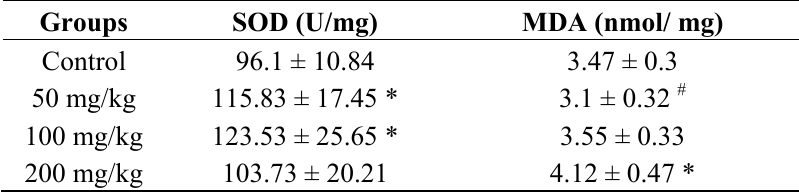
Table 1. Effects of icariin on SOD activity and MDA